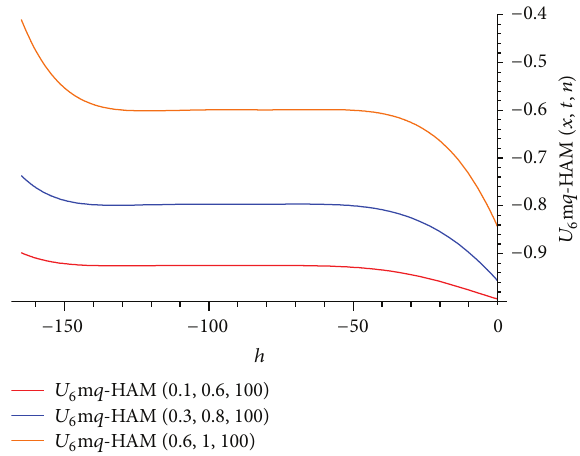
Figure 9: ℎ -curve for the 𝑛 HAM (m 𝑞 -HAM; 𝑛 = 1) approximation solution 𝑈 6 (𝑥,𝑡) of problem (40) at different values of 𝑥 and 𝑡 .